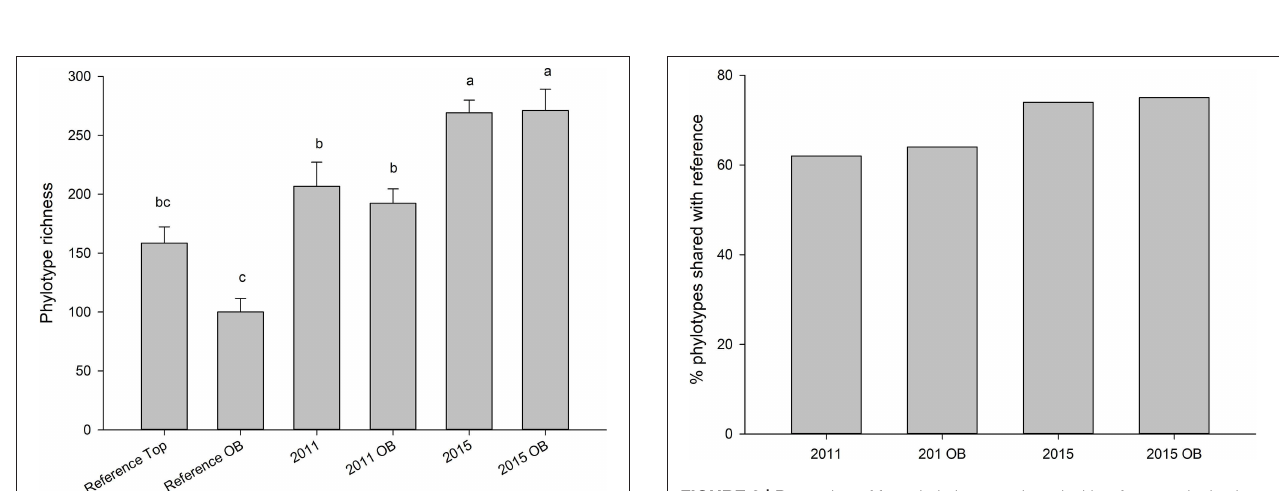
FIGURE 6 | Proportion of fungal phylotypes shared with reference site in sites receiving both standard topsoil transfer and overburden (OB). from topsoil only sites for 2011, 2015, or reference site ( p > 0.05) ( Figure 5 ). The proportion of phylotypes shared with reference site was similar for overburden treatments in 2011 (62% overburden vs. 64%) and 2015 (75% overburden vs. 74%) ( Figure 6